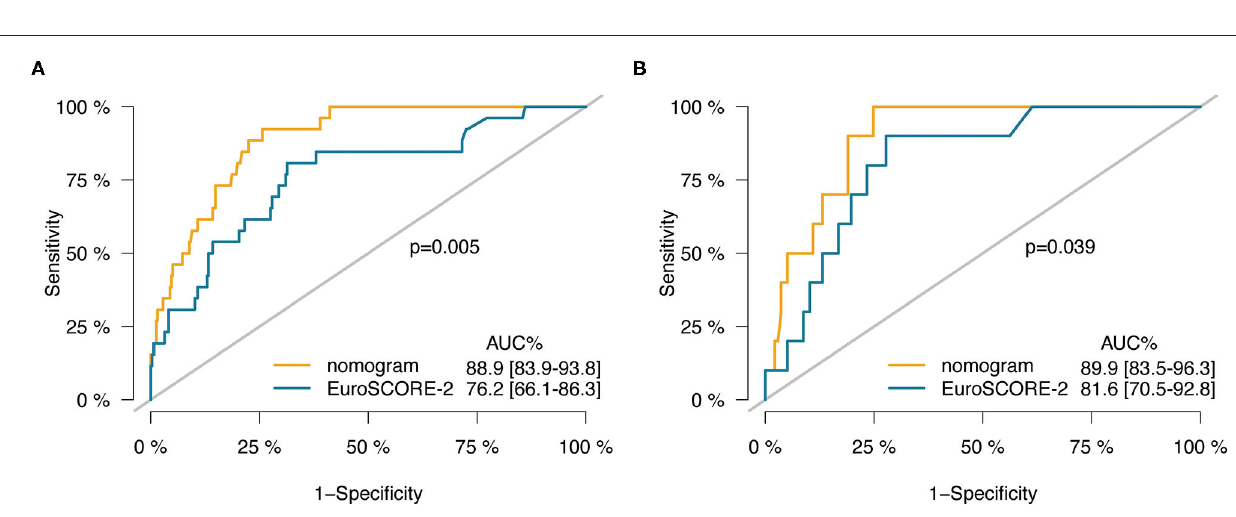
mortality in patients with LVEF < 30% undergoing isolated CABG. The results from Surgical Treatment for Ischemic Heart Failure (STICH) Trial (20) showed that, in patients with left